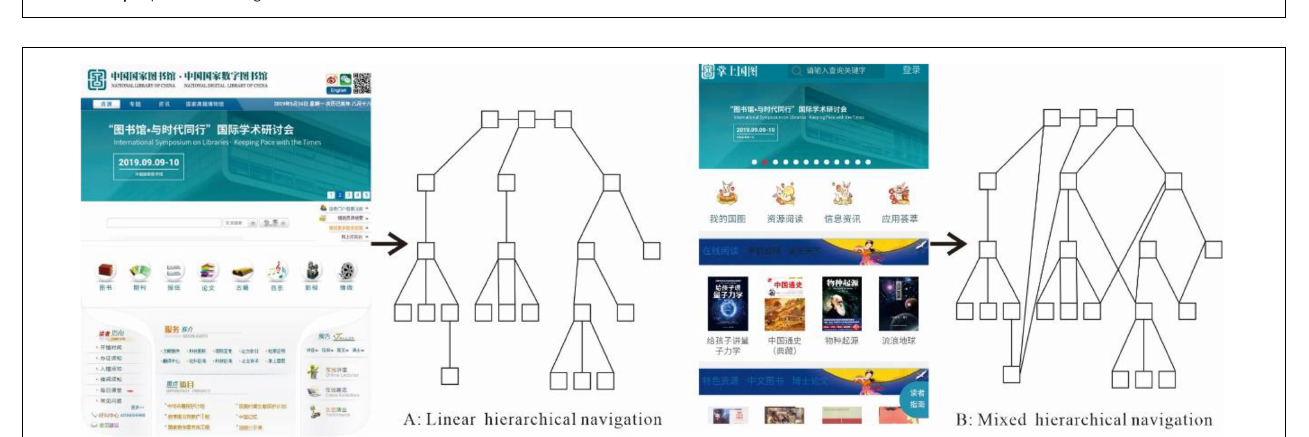
FIGURE 1 | Experiment design.